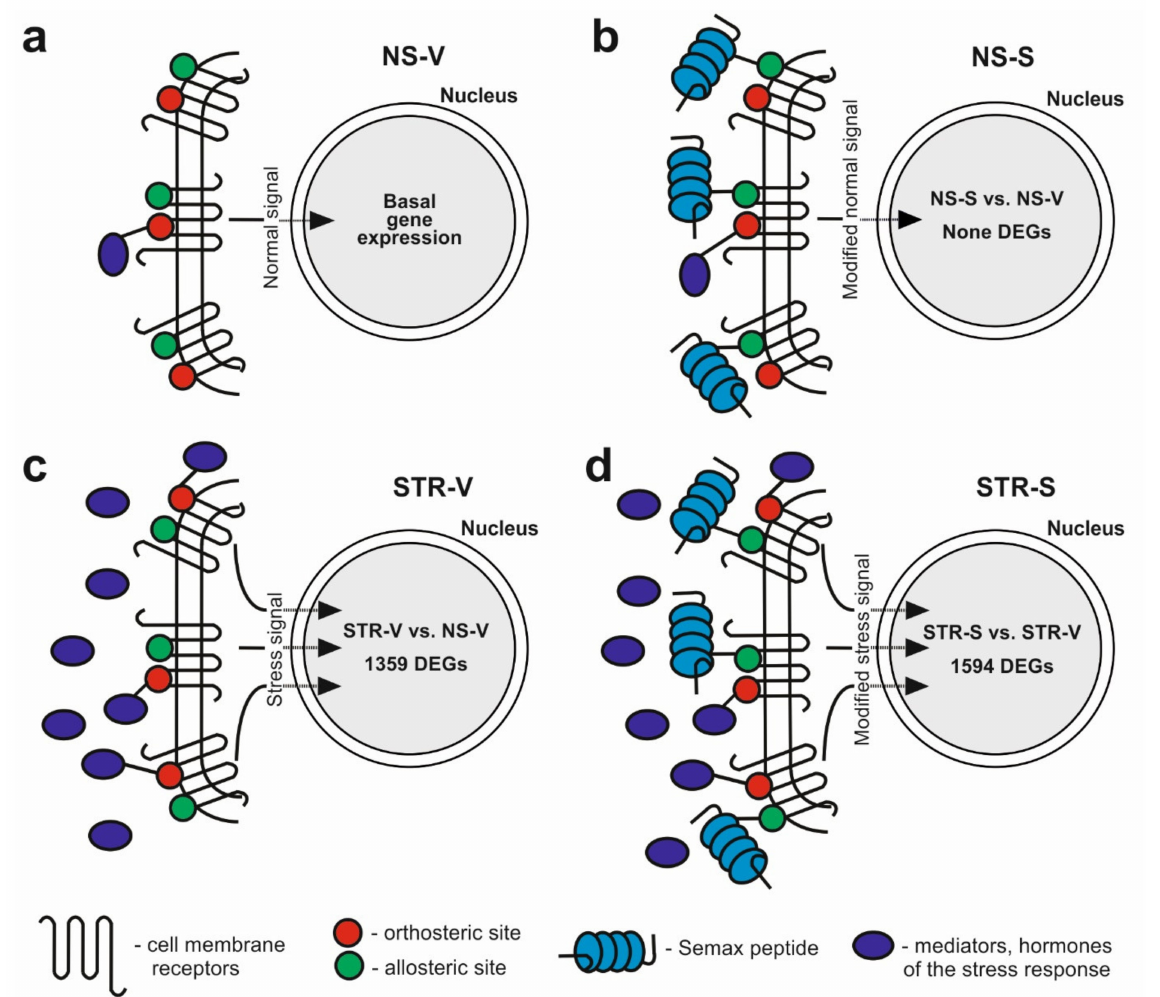
Figure 5. A model for the formation of a transcriptome response under normal and ARS conditions, and after MC peptide (e.g., Semax) administration. Four situations are considered: ( a ) non-stressed conditions without peptide treatment (NS-V); ( b ) Semax peptide action under non-stressed conditions (NS-S); ( c ) ARS conditions without peptide treatment (STR-V); ( d ) Semax peptide action under ARS conditions